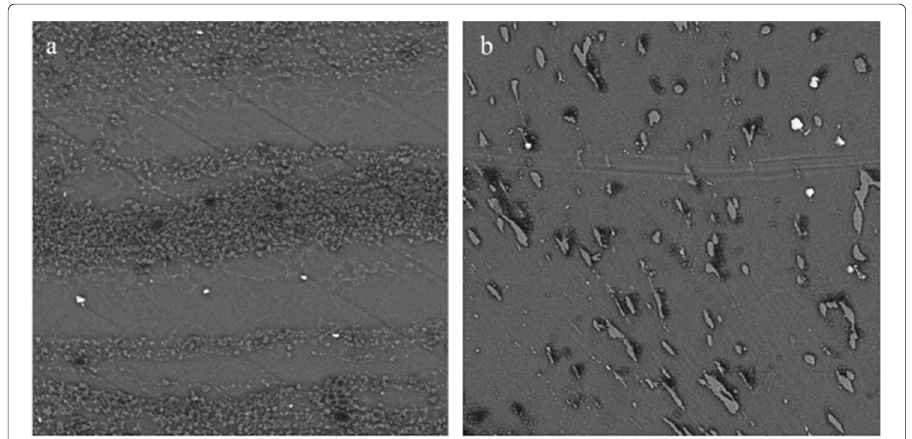
Fig. 4 SEM images of friction stirred AZ91D/ Al 2 O 3 processed at a RS= 800 rpm, TS = 40 mm/min, b RS = 800 rpm, TS = 80 mm/min